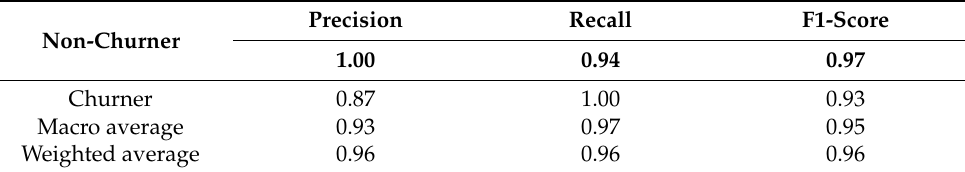
Table 8. Classification report.